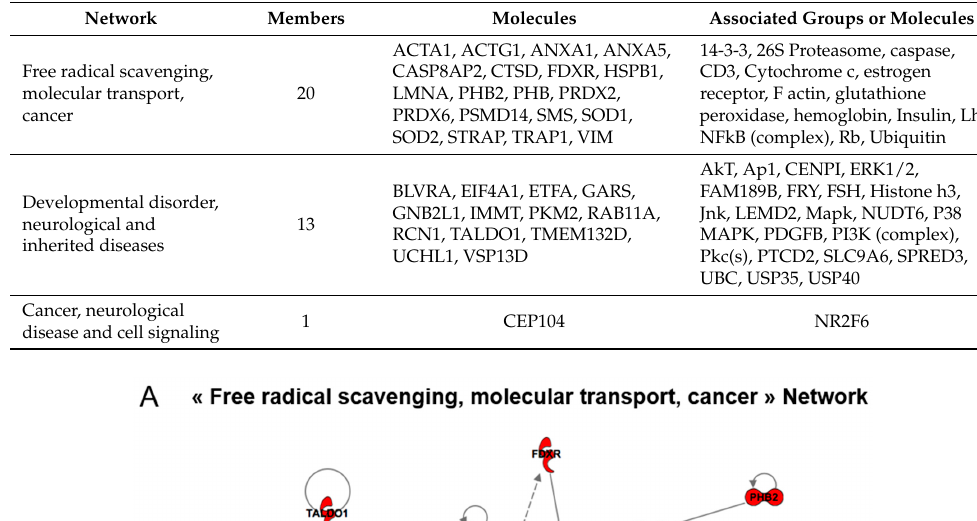
Table 2. Ingenuity pathway analysis of functional networks affected by replicative senescence.